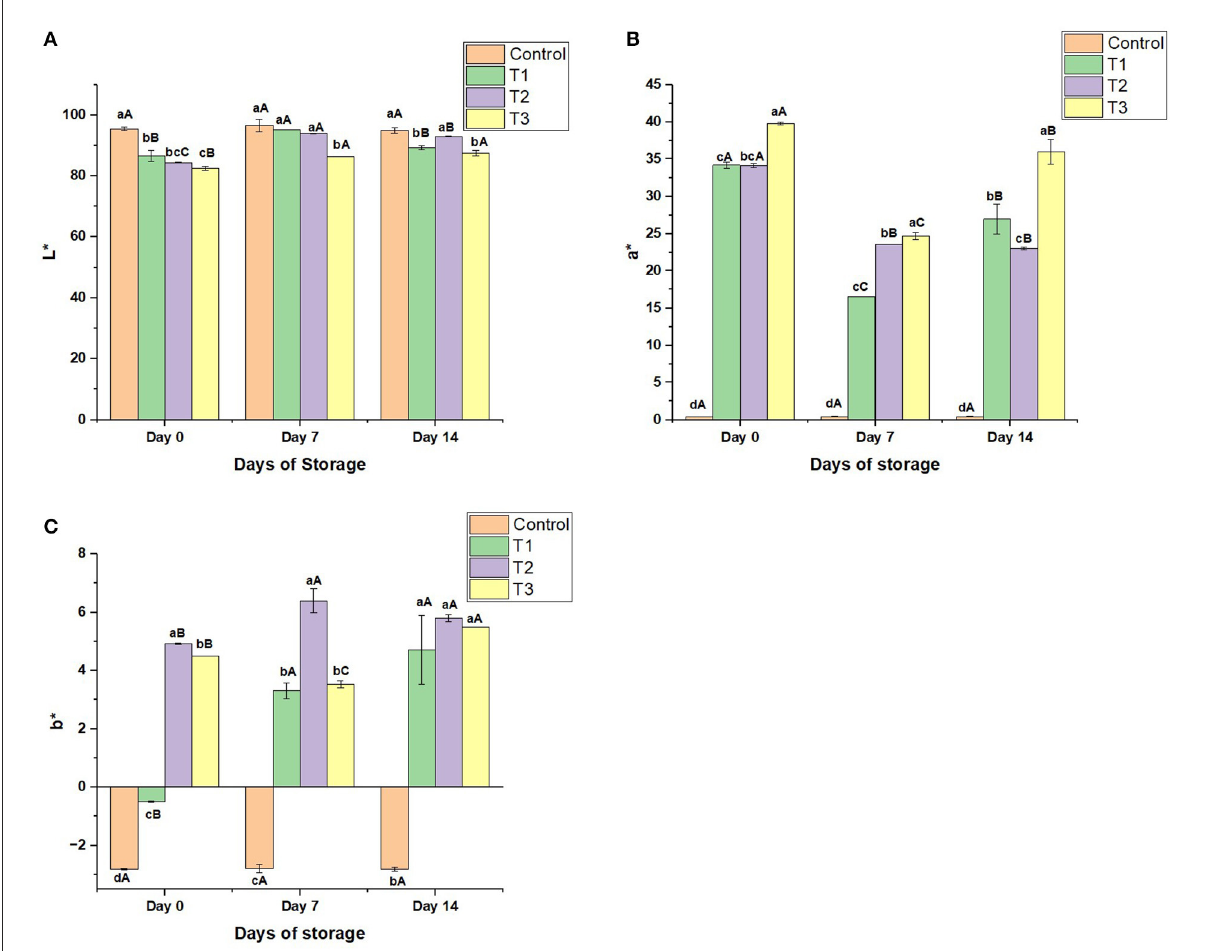
FIGURE3 (A) Lightness (L*) values, (B) Redness/greenness (a*) values, and (C) Blueness/yellowness (b*) values of control beverage and beverages enriched with beetroot peel extracts at different concentrations during 14 days of storage. Means with different lowercase letters (a–d) on the same storage day are statistically different ( p < 0.05). Means with different uppercase letters (A–C) for each treatment during the different storage days are statistically different ( p < 0.05).